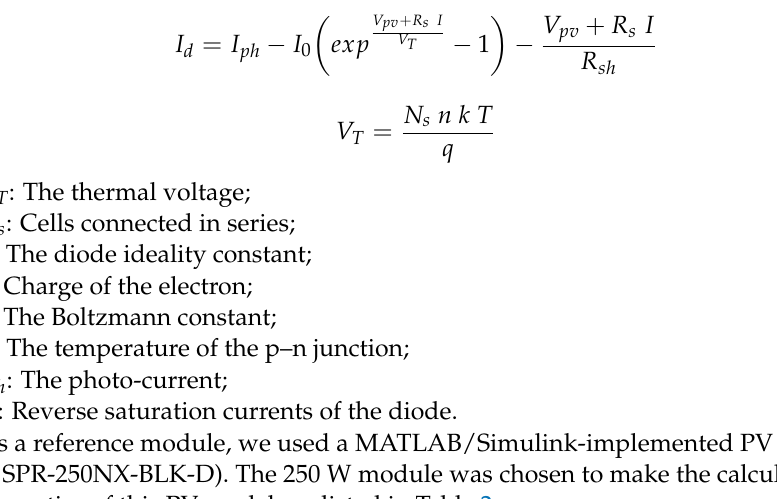
Figure 4. Equivalent electrical diagram of a photovoltaic cell.